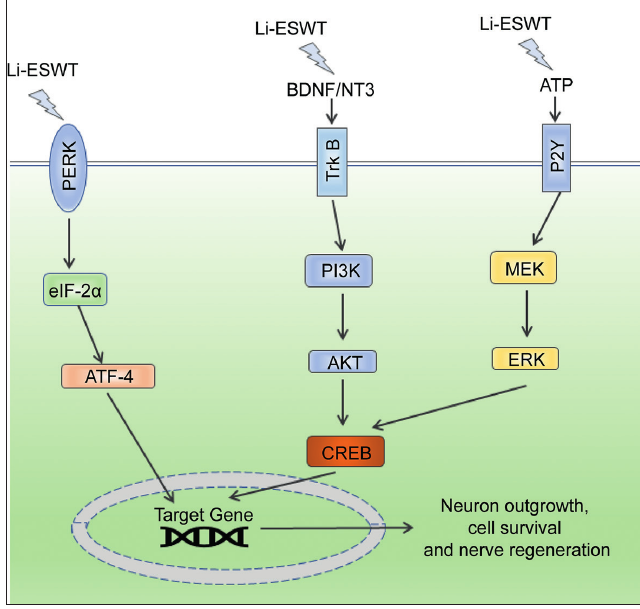
Figure 1. Cellular Signaling Pathways Regulated by Low- Intensity Extracorporeal Shockwave Therapy for Peripheral Nerve